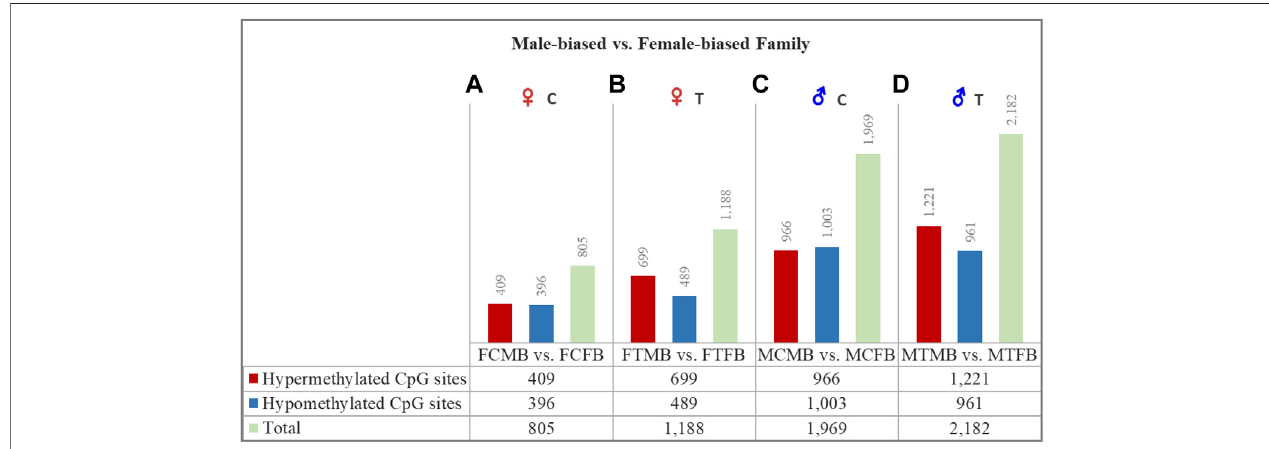
FIGURE 4 | Differentially methylated CpG sites (DMCs) in zebra fi sh gonad of male-biased versus female-biased family. Bar charts illustrate DMCs in ovaries in control (A) and treatment (B) groups of male-biased vs. female-biased family (FCMB vs. FCFB and FTMB vs. FTFB, respectively), and in testes in control (C) and treatment (D) groups of male-biased vs. female-biased family (MCMB vs. MCFB and MTMB vs. MTFB, respectively).